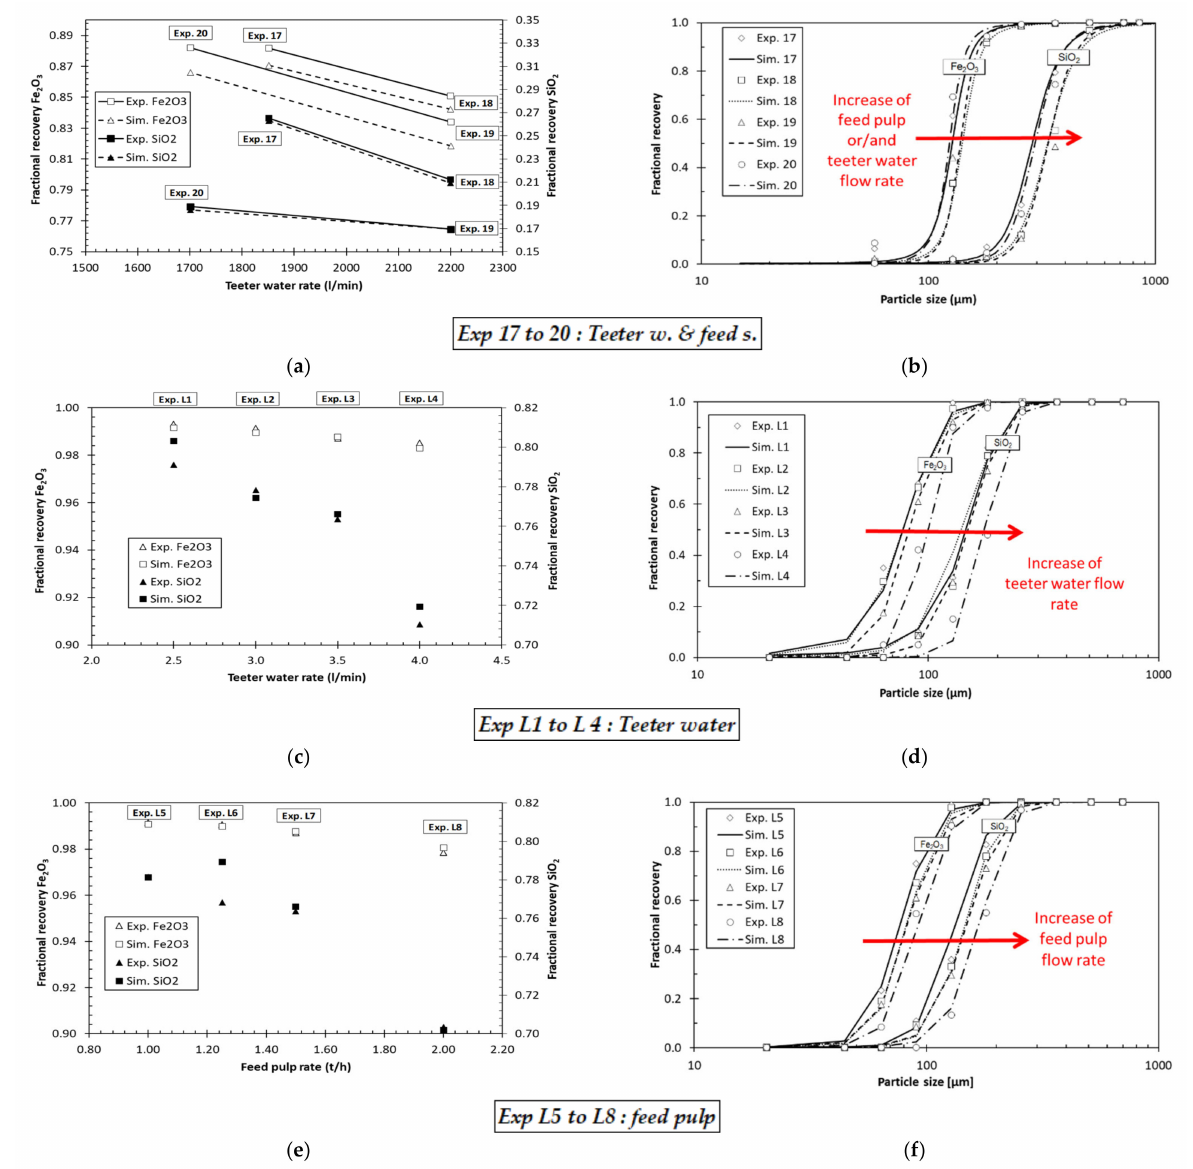
Figure 10. Fractional recovery of Fe 2 O 3 , SiO 2 in underflow as a function of; ( a , b ) teeter water and